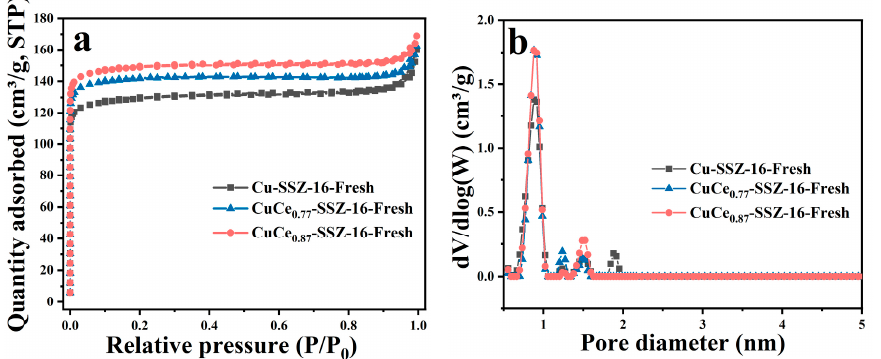
Figure 3. ( a ) N 2 adsorption–desorption isotherms and ( b ) Pore-size distribution spectra of Cu-SSZ- 16-Fresh, CuCe 0.77 -SSZ-16-Fresh, and CuCe 0.87 -SSZ-16-Fresh.